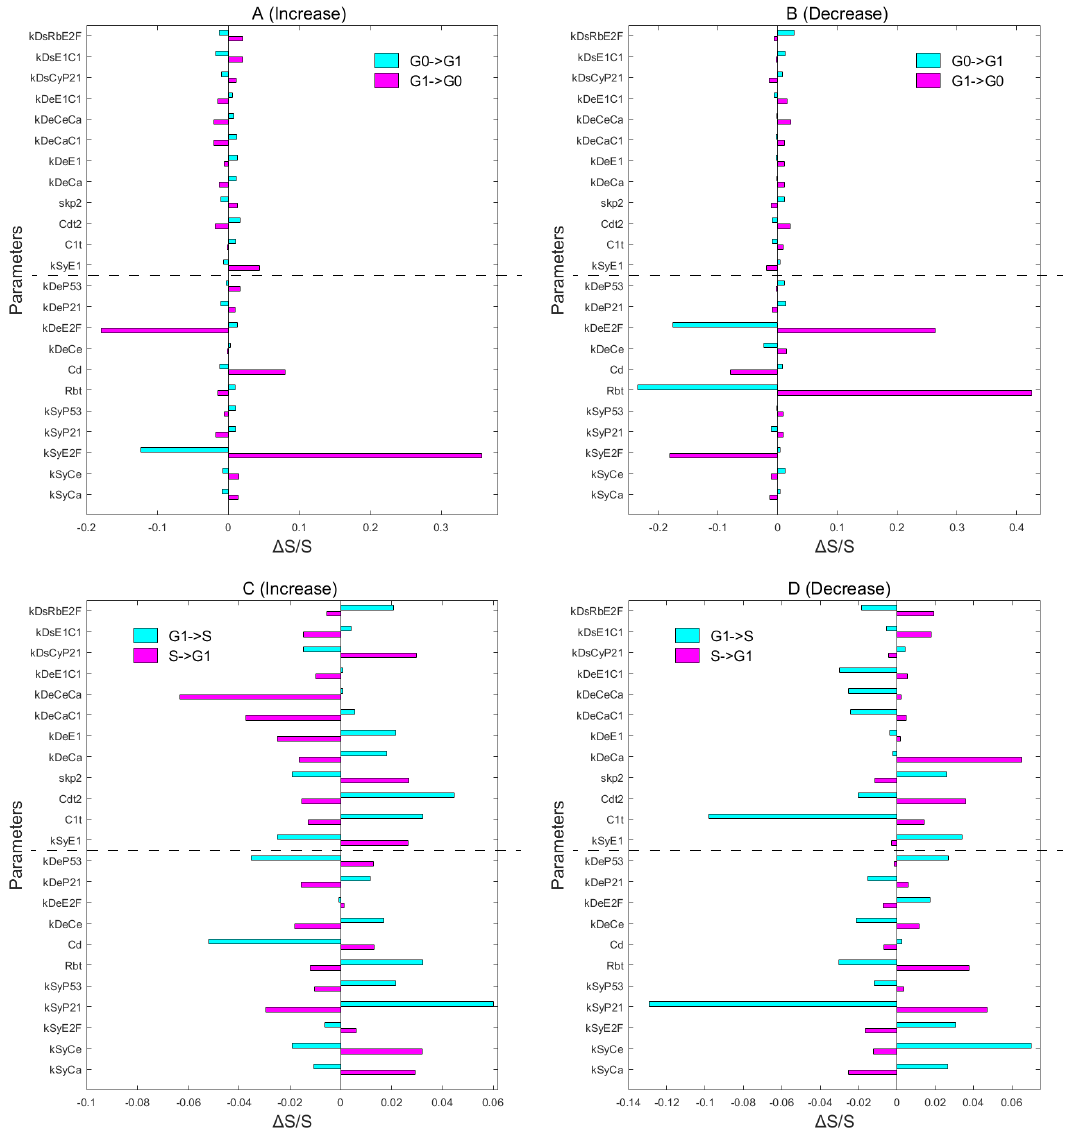
Figure 6. Sensitivity analysis for the 23 parameters on the transition action of G0- > G1 ( A ), G1- > G0 ( B ), G1- > S ( C ), and S- > G1 ( D ). The x axis represents the relative change of transition action in terms of unperturbed system, denoted by ∆ S/S. Some sensitive parameters were increased or reduced by 0.5% (below the dotted line), including kSyCe, kSyCa, kSyE2F, kSyP21, kSyP53, Rbt, Cd, kDeCe, kDeE2F, kDeP21, abd kDeP53, while the other parameters were increased or decreased by 5% (above the dotted line). ( A , B ) the magenta bar represents the G1- > G0 transition, and the cyan bar represents the G0- > G1 transition. ( A ) Each parameter was increased for the transition between G0 and G1. ( B ) Each parameter was decreased for the transition between G0 and G1. ( C , D ) The magenta bar represents the S- > G1 transition, and the cyan bar represents the G1- > S transition. ( C ) Each parameter was increased for the transition between G1 and S. ( D ) Each parameter was decreased for the transition between G1 and